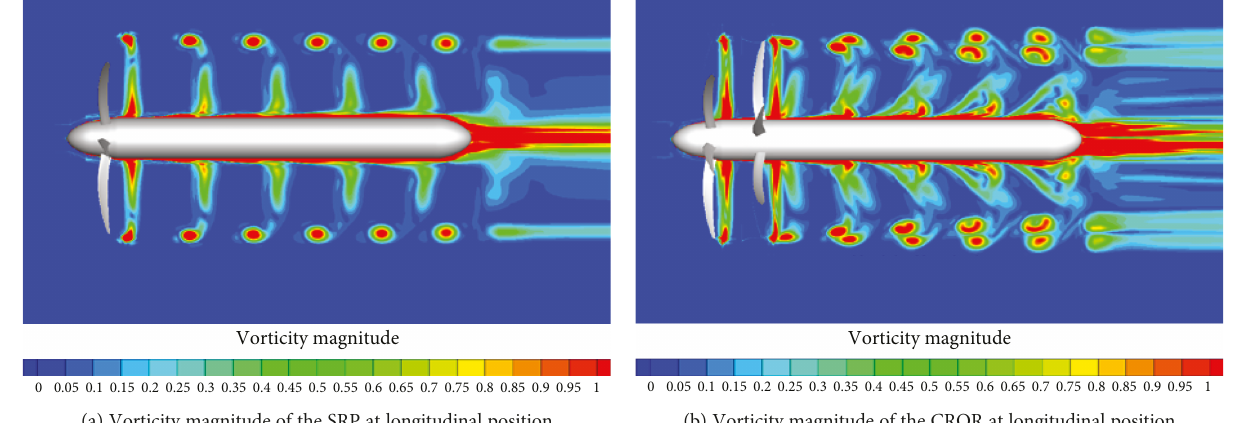
Figure 11: Cross section vorticity magnitude; J = 1 73779 .